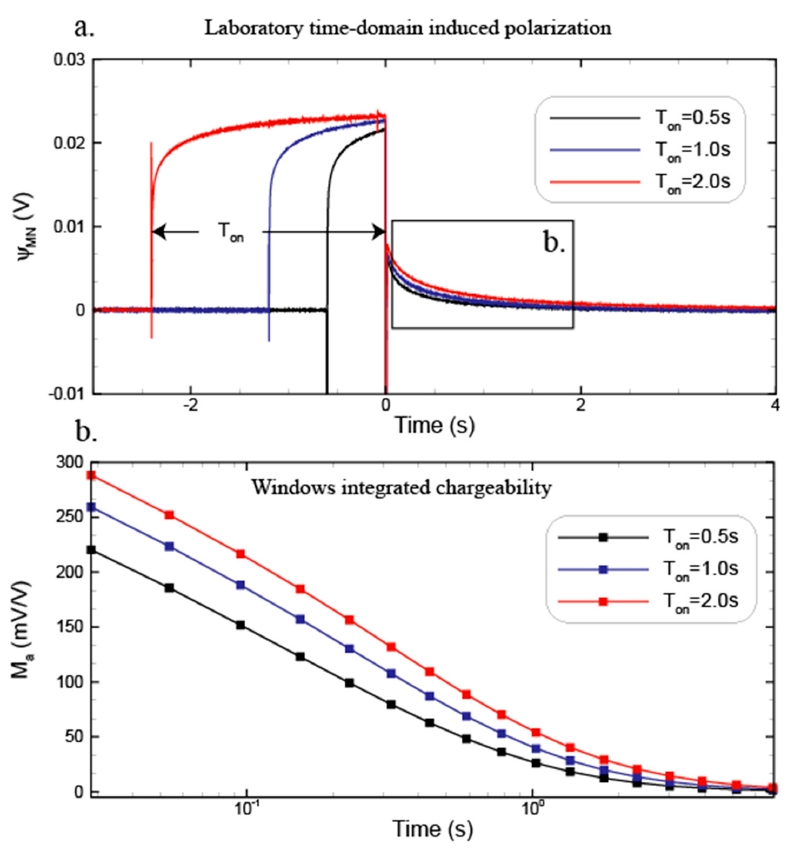
Figure 2. Laboratory experiment showing the secondary voltage decay for three periods of the injected current. ( a ) Difference in potential recorded between electrodes M and N. The current is injected between A and B for a period ( T on ). ( b ) Time-window-integrated chargeability for the apparent chargeability ( M a ) (here expressed in mV/V). This decay illustrates the decay of the secondary voltage over time, which is associated with the charge carriers returning to their equilibrium positions by electro-diffusion.